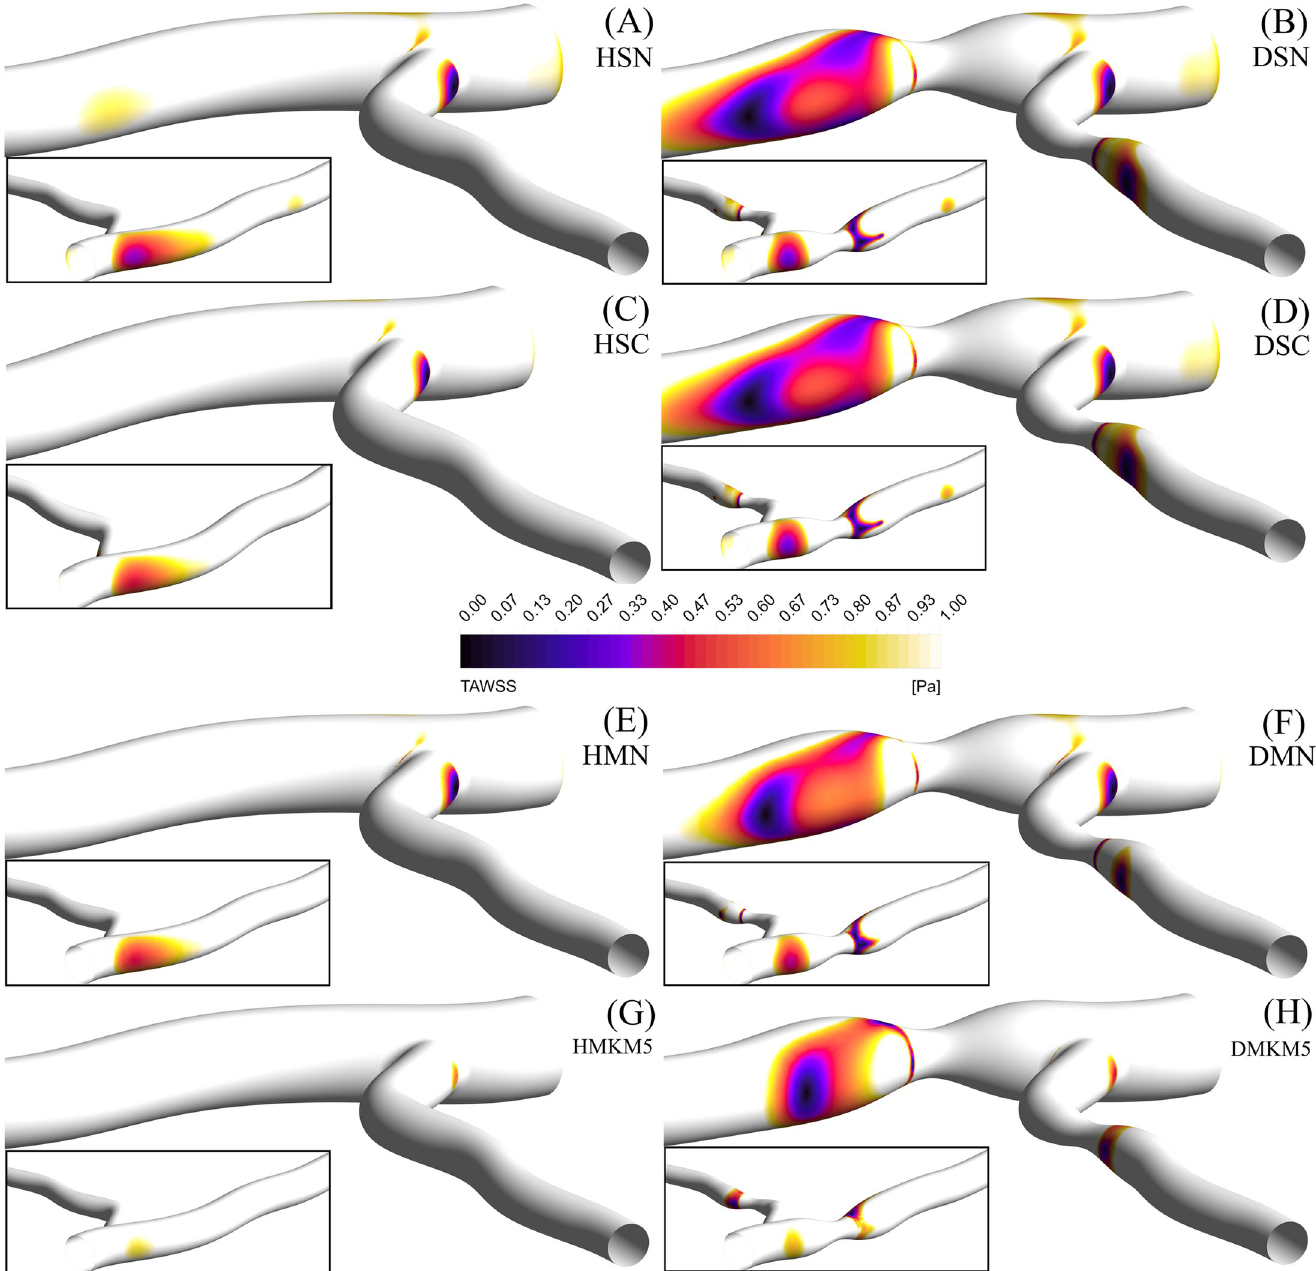
Fig 7. TAWSS contours of regions < 1 Pa, for the left coronary bifurcation for the single Newtonian healthy (A) and diseased (B) cases, single Carreau healthy (C) and diseased (D) cases, multi Newtonian healthy (E) and diseased (F) cases, and the multi MKM5 healthy (G) and diseased (H) cases, with the reverse angle inlaid. https://doi.org/10.1371/journal.pone.0259196.g007 Despite a uniform hematocrit inlet condition of 0.45 for both models, there is a significant dif- ference in RBC concentration and hence phase transport between the two models. The MN model shows minimal deviation from the uniform distribution, even in the significantly dis- turbed flow occurring at the flow divider and the outer walls of the stenosis. The increased RBC transport arising in the MKM5 model predicts large regions of the artery with both